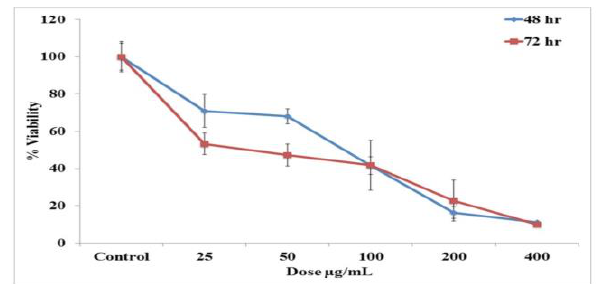
Figure 7: Treating human MSCs at various doses for 48 and 72 H and studying the cell viability [61]